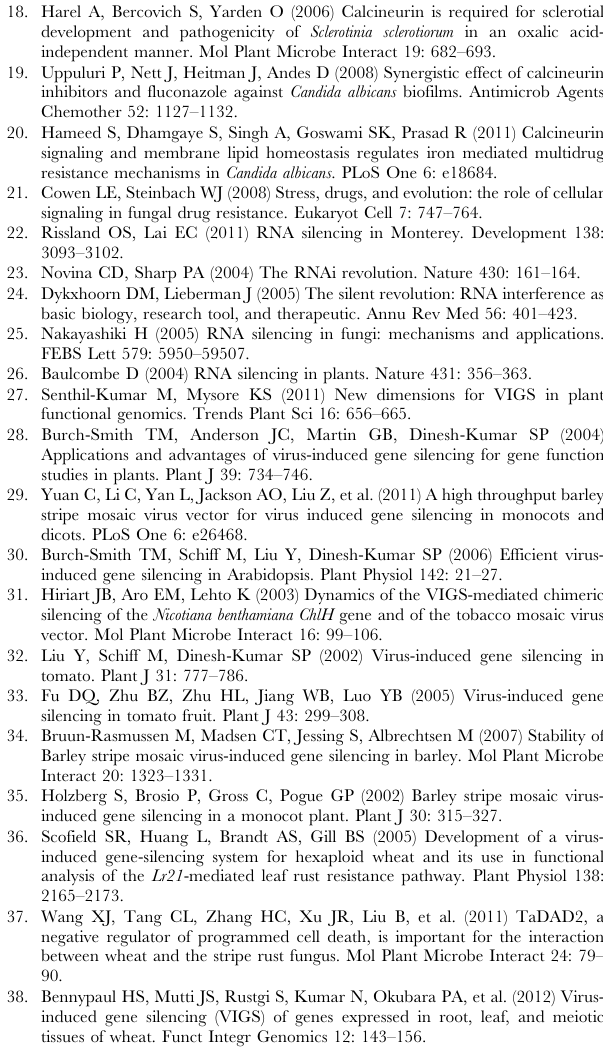
Figure S1 Comparison of Ps CNA1 to other homologous CNA proteins. Cn CNA ( Cryptococcus neoformans var. grubii , AAB97372), Pg CNA, ( Puccinia graminis tritici , EFP89050), Ps CNB ( Puccinia striiformis f. sp. tritici , JX424819), Pt CNA ( Puccinia triticina , PTTG_07903), Ss CNA ( Sclerotinia sclerotiorum , XP_001597594), Um CNA ( Ustilago maydis , AAP48999). The solid arrow lines show the STPHPHTASE (Serine/threonine-protein phosphatase do- mains) domains and the dashed line shows the Cacineurin A Domain. Shaded regions show the same AA.